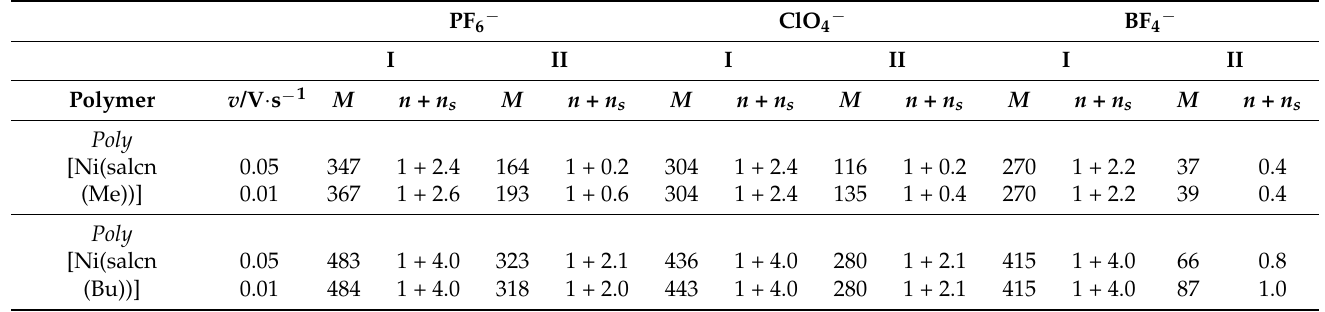
Table 2. Molar mass ( M /g · mol − 1 ) obtained from the slopes of ∆ m = f( Q ) plots and molar participa- tions of ions and solvent ( n + n s ) in oxidation of poly [Ni(salcn(Me))] and poly [Ni(salcn(Bu))] (obtained as a result of 1 electropolymerization cycle) in various electrolyte solutions (10 − 1 mol · dm − 3 ), in CH 2 Cl 2